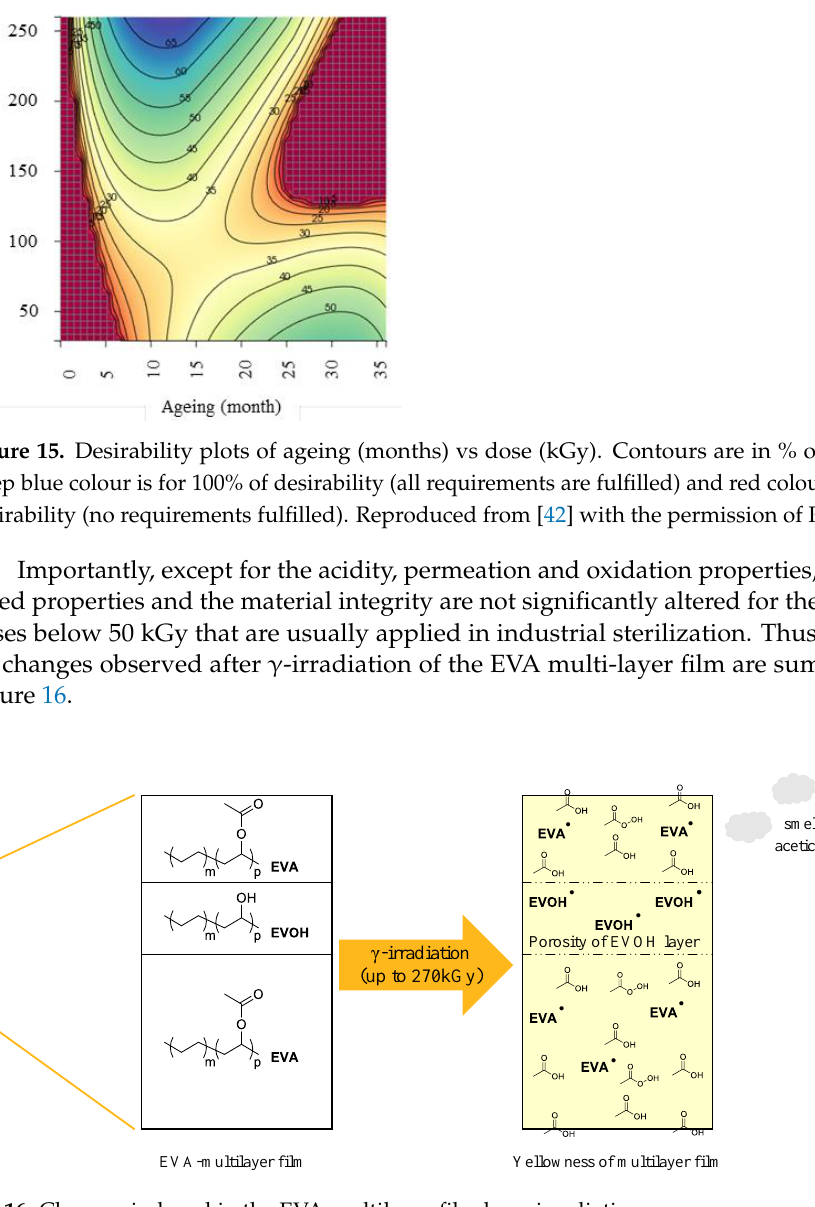
Figure 16. Changes induced in the EVA multilayer film by γ-irradiation .